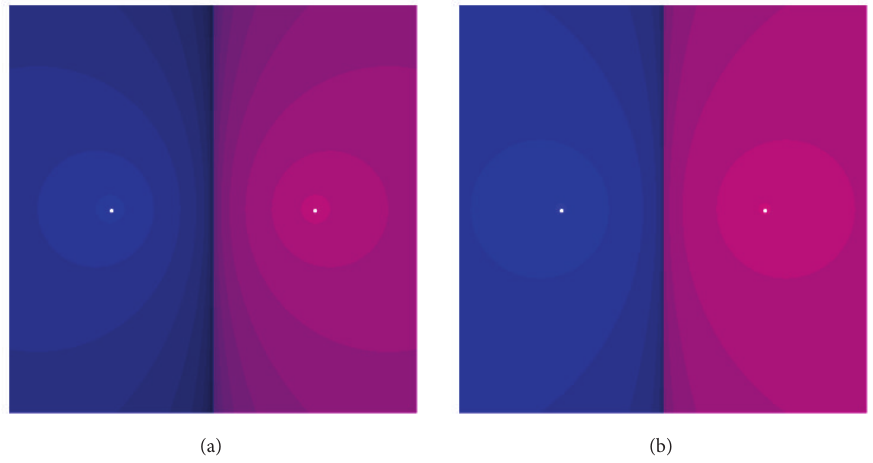
Figure 1: Attraction basins for (6) (a) and (8) (b) for the polynomial 𝑔(𝑥) = 𝑥 2 − 1